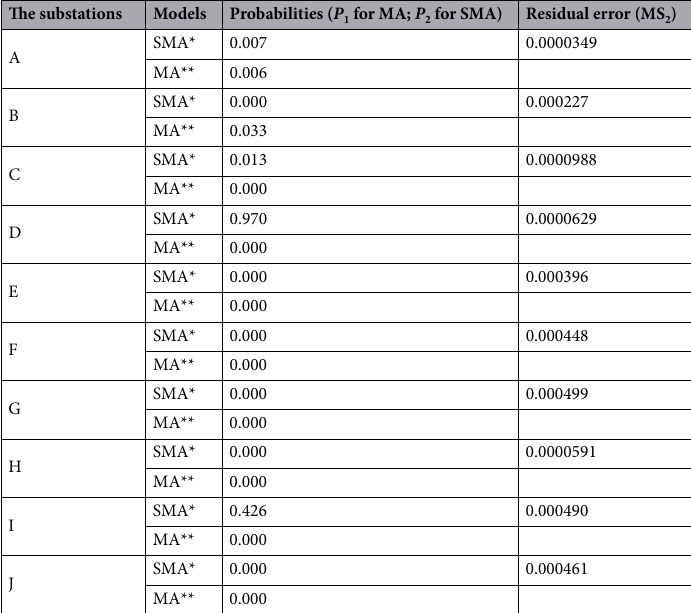
The substations Models Probabilities ( P 1 for MA; P 2 for SMA) Residual error (MS 2